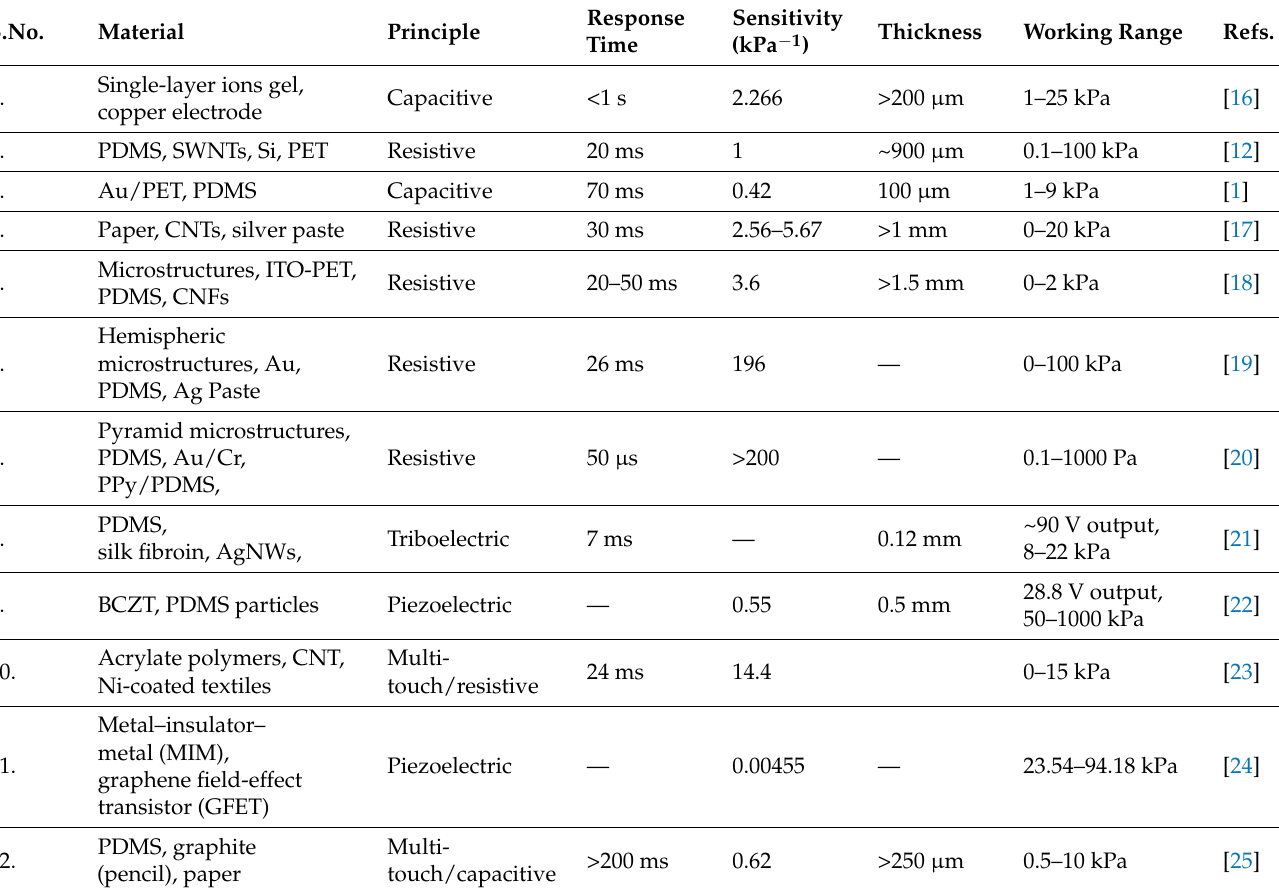
Table 2. Summary of various sensors and sensing systems in terms of electrical and mechanical